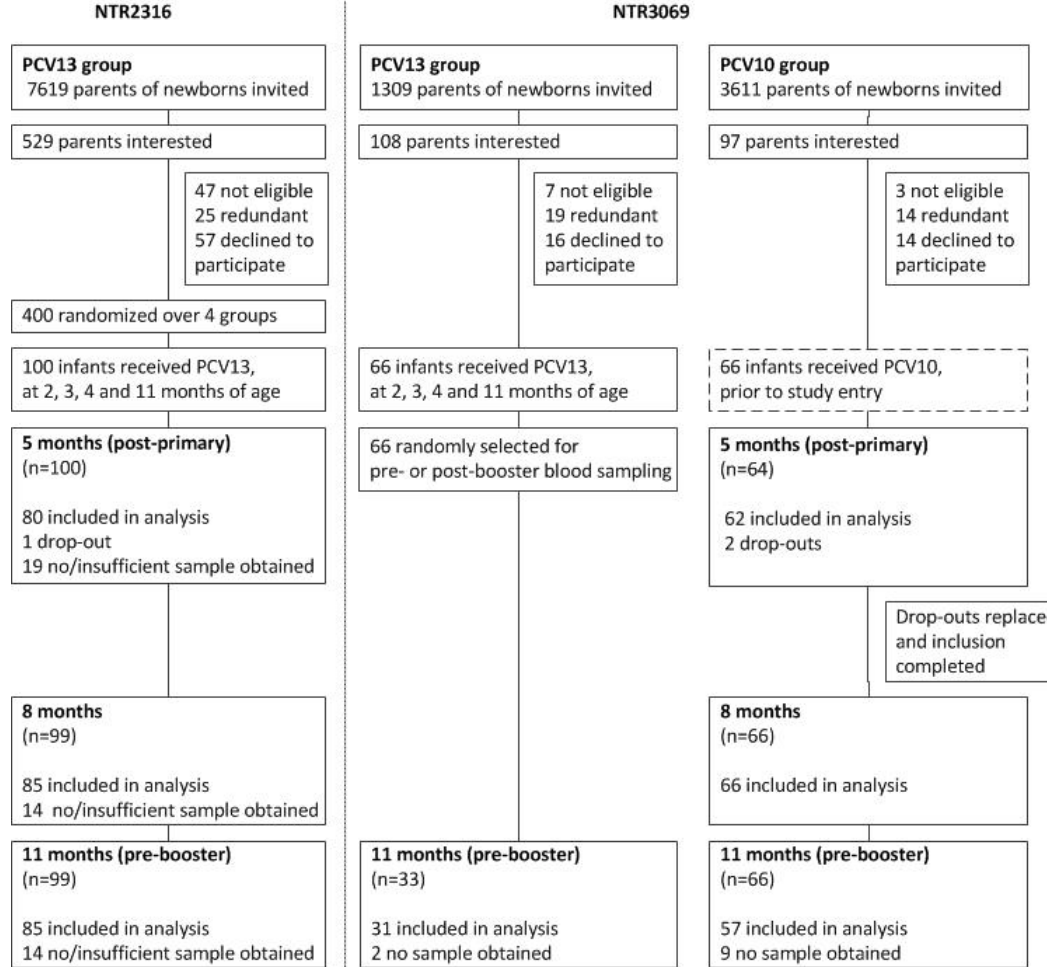
Figure 1. Study design and disposition of subjects in clinical trials NTR2316 and NTR3069.